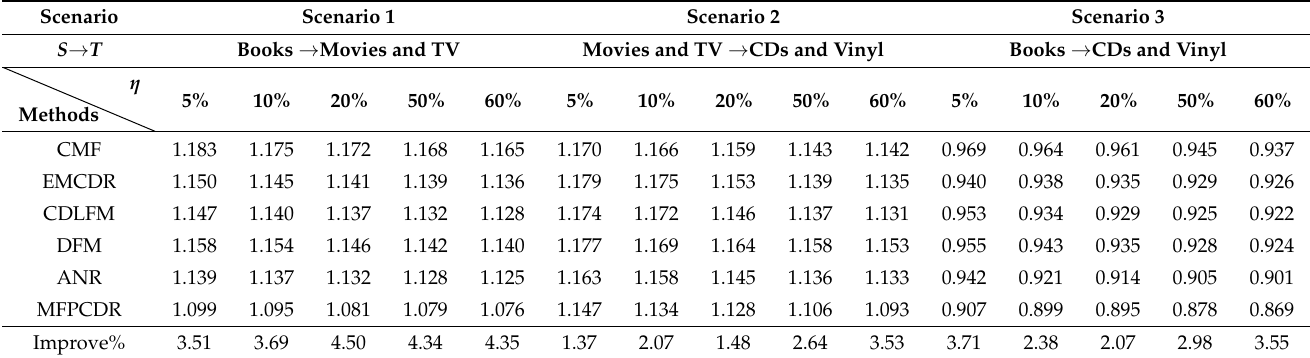
Table 2. Comparison of MSE in three cross-domain recommendation